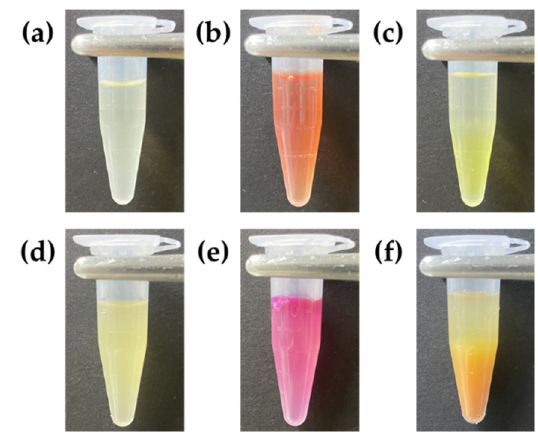
Figure 10. Identification of bacterial metabolite with phenol red and Nessler’s reagent. ( a ) Only LB broth, ( b ) LB broth with phenol red, ( c ) LB broth with Nessler’s reagent, ( d ) E. coli K-12 ( e ) E. coli K-12 with phenol red and ( f ) E. coli K-12 with Nessler’s reagent.